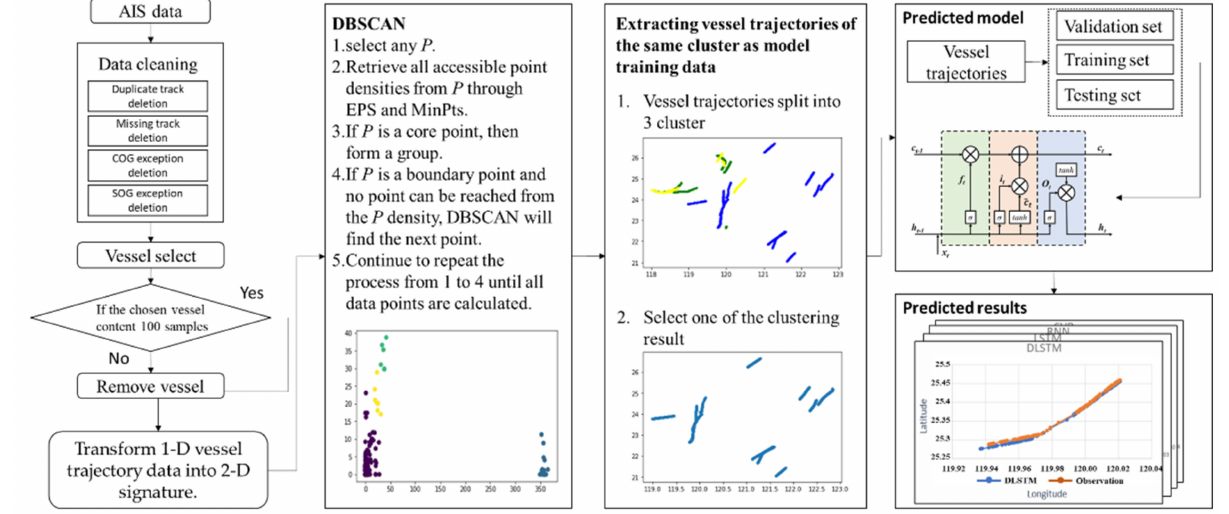
Figure 1. Flowchart of the study